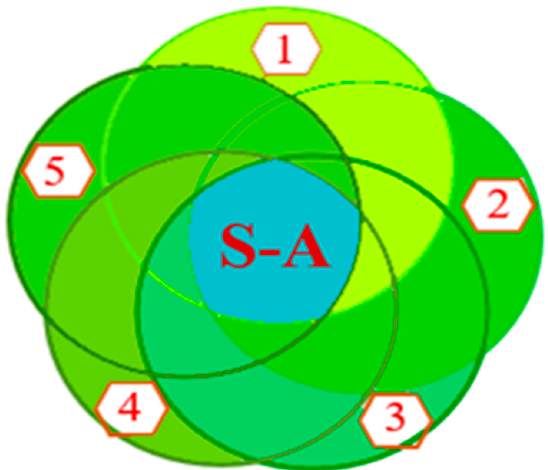
Figure 19. Analysis process of the BCPPSAs’ performances.